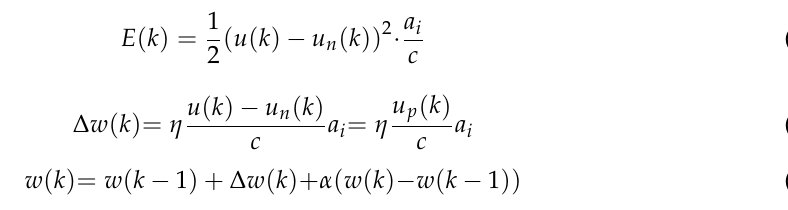
Figure 9. A CMAC and PID composite control structure diagram.